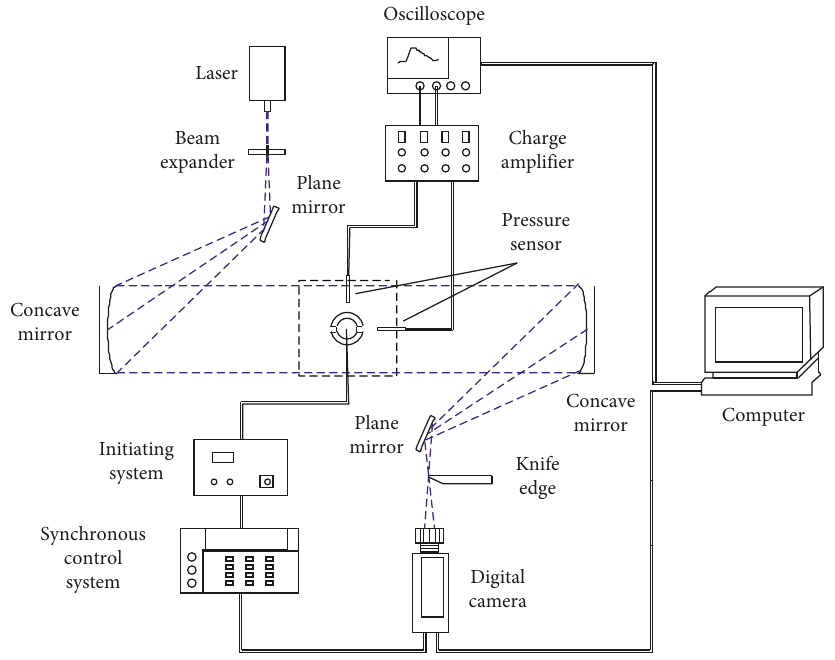
Figure 2: High-speed schlieren photography experimental system.